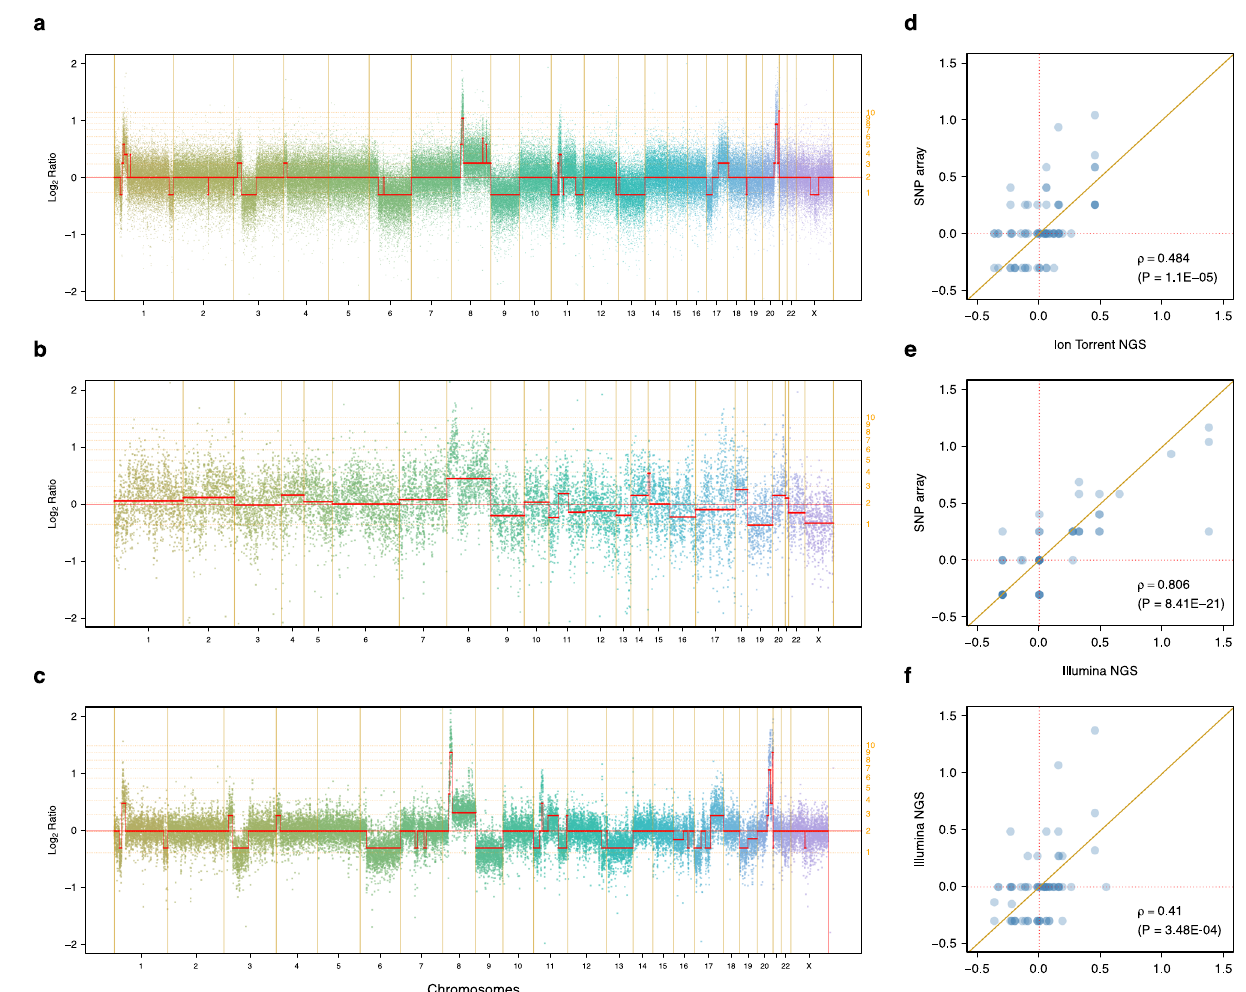
Fig. 4 Genome-wide copy number pro fi les inferred from SNP arrays and targeted NGS data. Genome-wide Log 2 ratio pro fi les of patient IJB0021 obtained using a SNP array b Ion Torrent and c Illumina targeted NGS data. The solid vertical lines represent chromosome boundaries whilst the dashed horizontal lines indicate canonical copy numbers inferred from the cancer cell fraction and ploidy of the sample, both estimated from the SNP array. The solid horizontal lines represent the segmented Log 2 ratios. Correlation of segmented Log 2 ratios between d the SNP array and the Ion Torrent platform, e the SNP arrays and the Illumina platform, and f the two NGS platforms for the same case patient. In a – c , the loci are sorted according to their coordinate on the human genome reference hg19/GRCh37. For ease of representation, they are plotted by